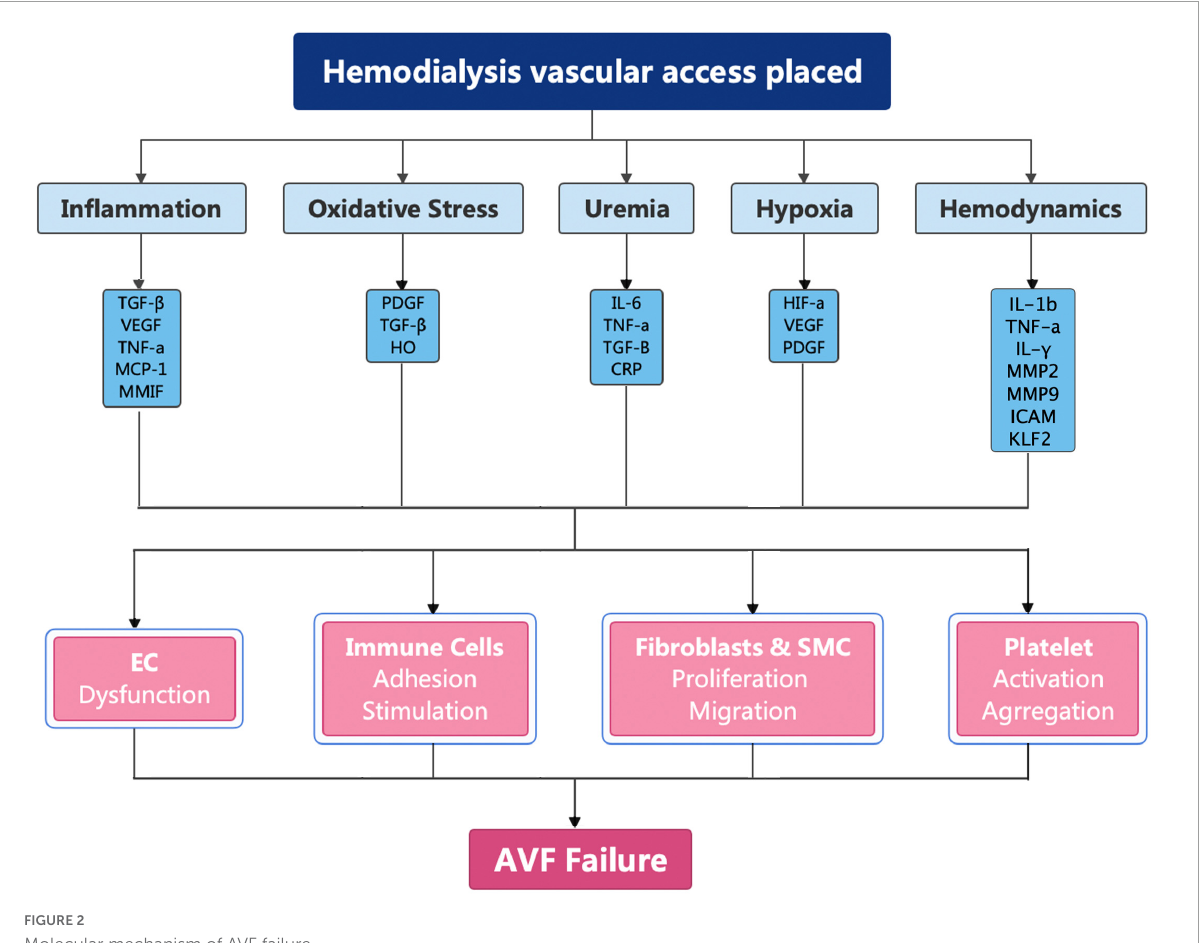
FIGURE2 Molecular mechanism of AVF